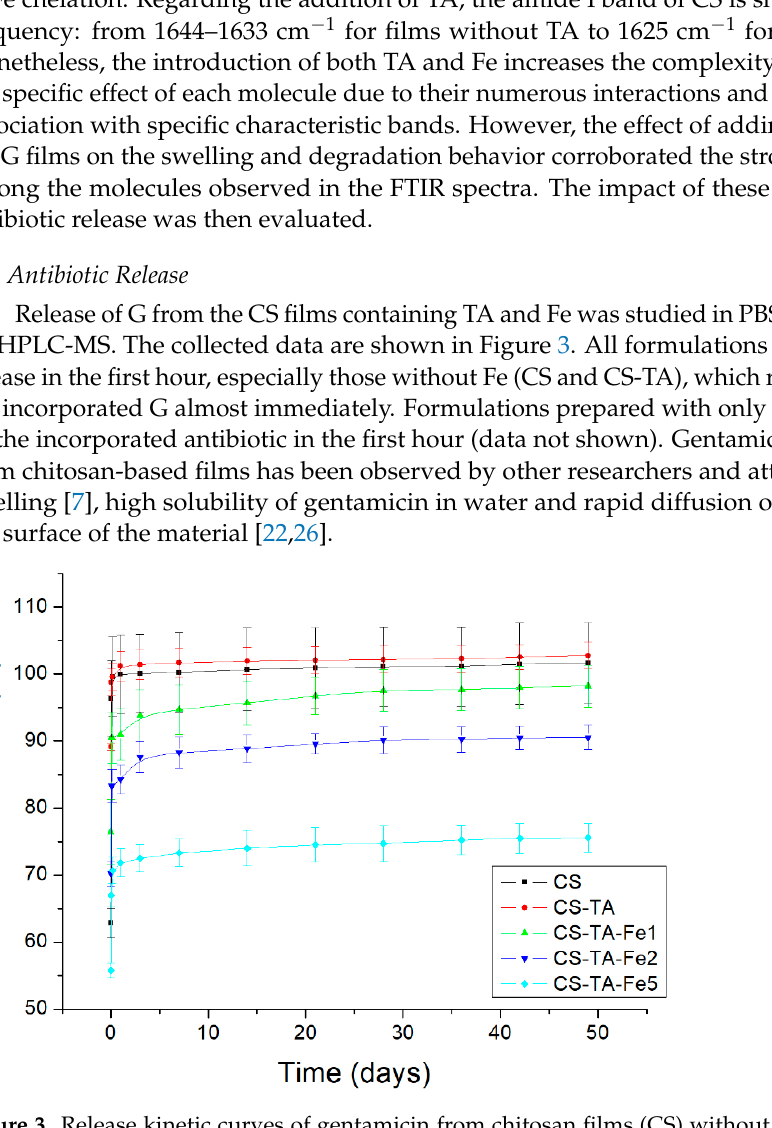
Figure 3. Release kinetic curves of gentamicin from chitosan films (CS) without crosslinking and crosslinked with tannic acid (TA) and iron (Fe) at different concentrations. The figure shows the mean cumulative release ± SD measured at each time point.